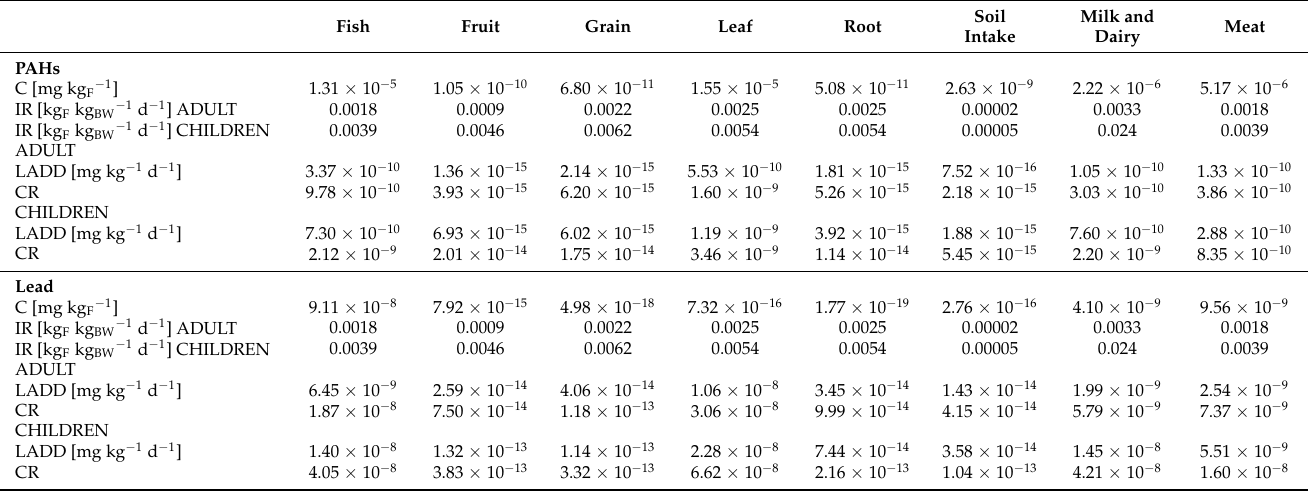
Table 8. Cancer Risk for PAHs and Lead from ingestion (soot emissions under the Italian legal threshold).